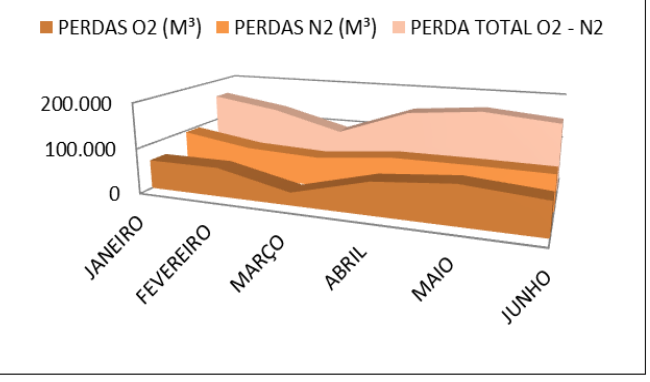
Figura 6. Perda mensal de O 2013.